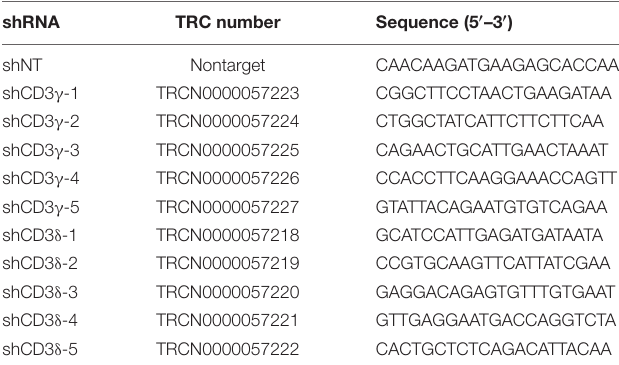
TABLE 1 | shRNA sequences have been previously published in The RNAi Consortium (TRC) and were purchased from Sigma-Aldrich cloned into pLKO.1